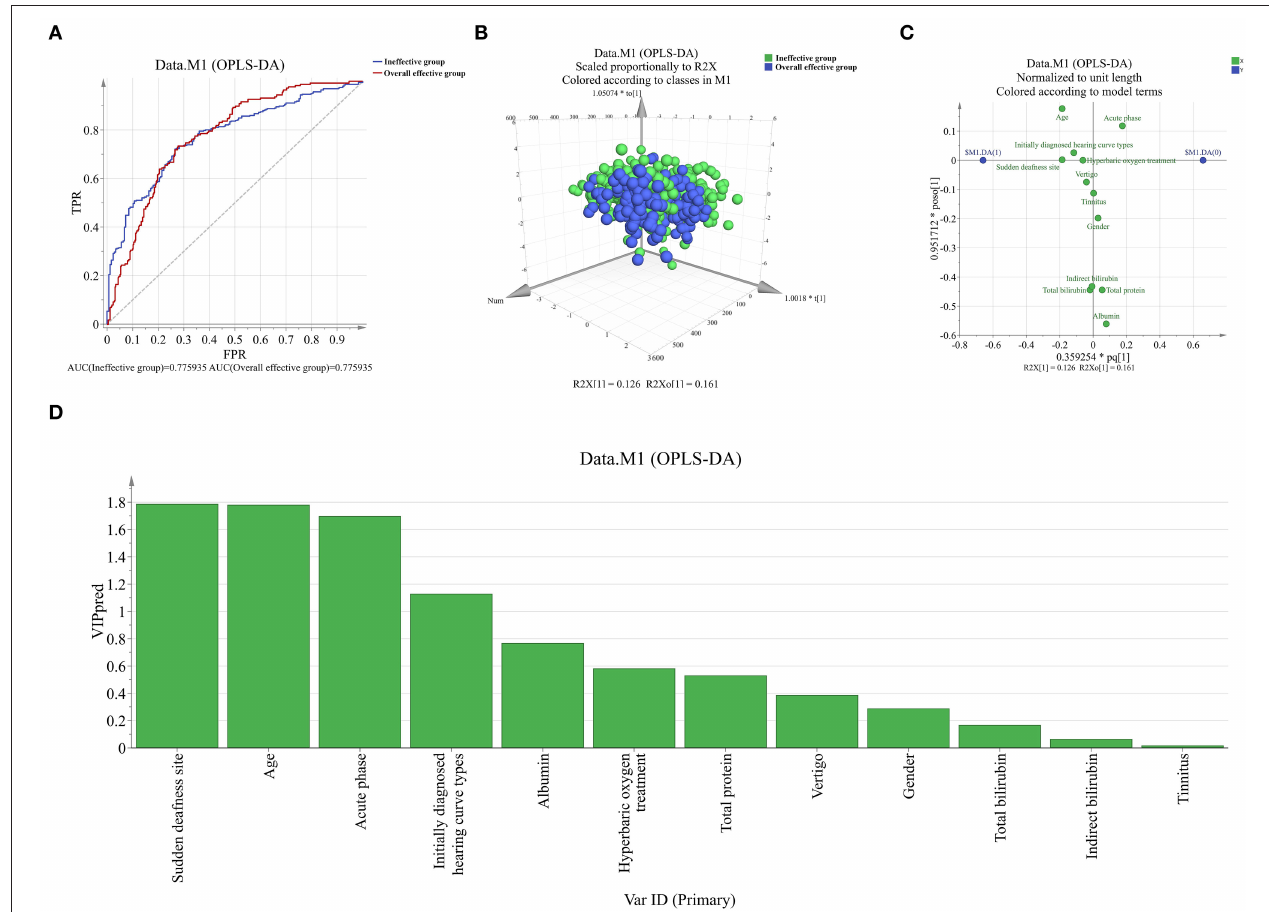
FIGURE 1 | Orthogonal partial least squares discriminant analysis (OPLS-DA) assessed the ability of risk factors to predict the prognosis of patients with sudden deafness (A,B) . Through OPLS-DA, patients in the overall effective group could be unambiguously distinguished from patients in the ineffective group; (C,D) . Sudden deafness site was considered as the top 1 indicator with highest predictive